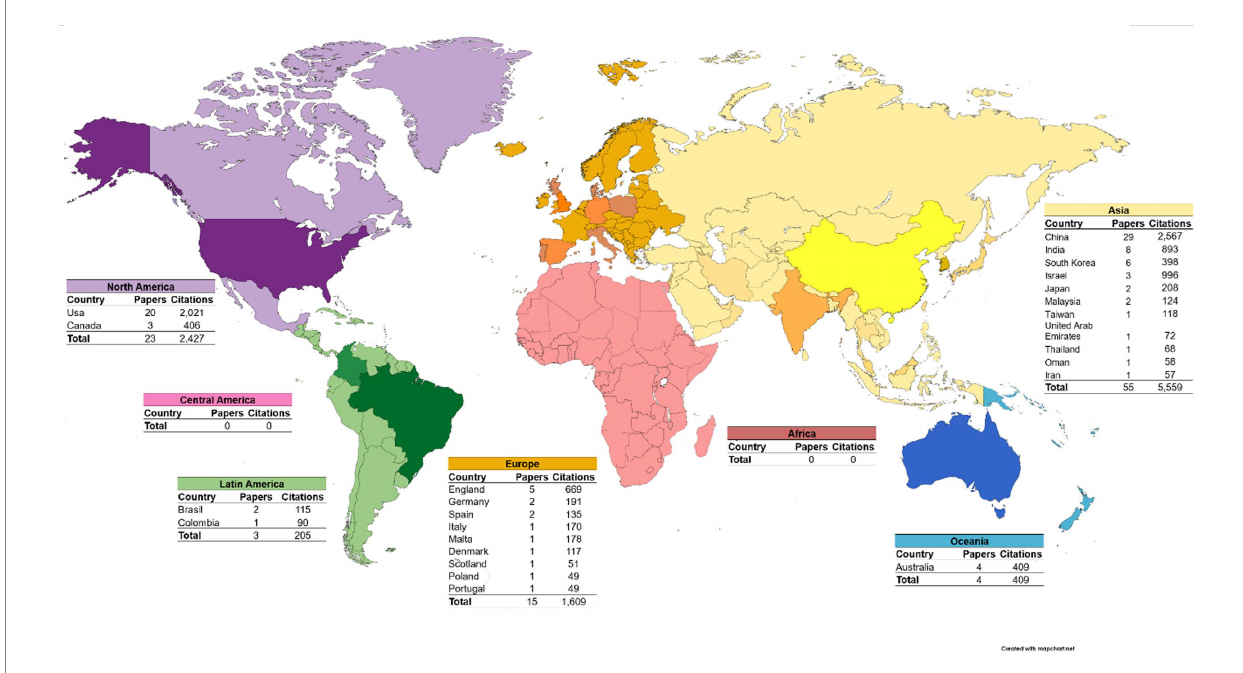
FIGURE 4 Worldwide distribution of the 100 most cited articles in PD and PC. Countries from the same continent are represented by the same color. The intensity of the color varies according to the presence or absence of publications with a high number of citations on PD and CP by country. Countries with stronger color intensity have publications with a high number of citations on PD and